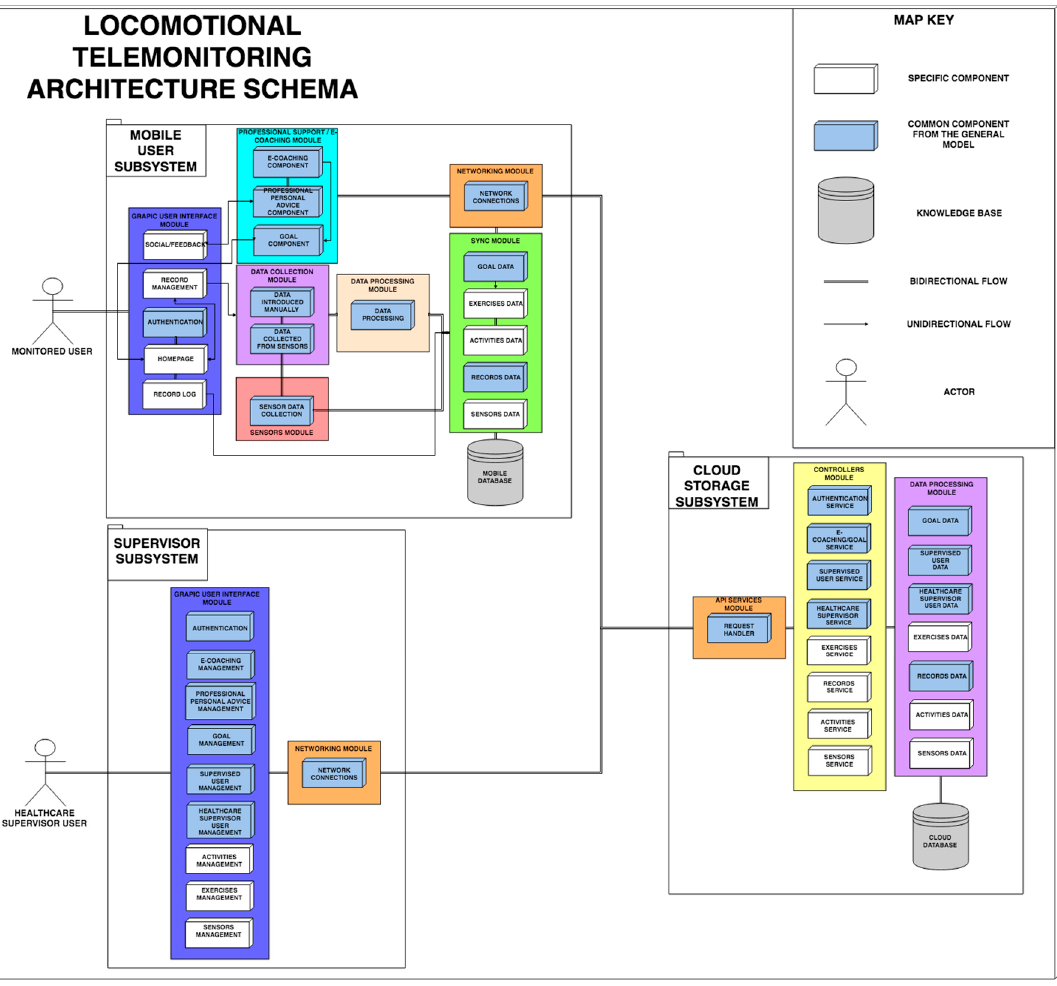
Figure 6. Architecture for locomotion telemonitoring (TrainME).